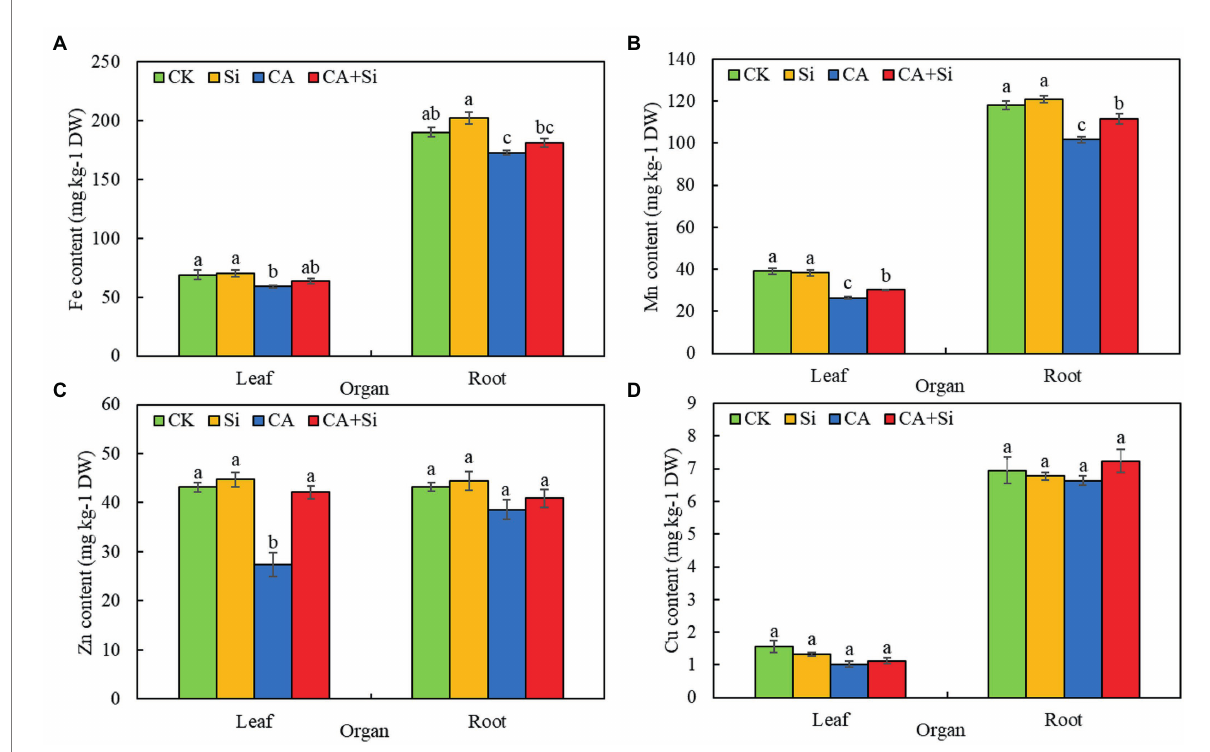
FIGURE 3 Effect of exogenous Si on the Fe (A) , Mn (B) , Zn (C) , and Cu (D) contents of leaves and roots in cucumber seedlings under cinnamic acid-induced autotoxicity stress. The values (mean ± SE) represent data from three replicates ( n = 3; each replicate contains three cucumber seedlings). Different lowercase letters indicate significant differences according to Duncan’s multiple range test ( p <